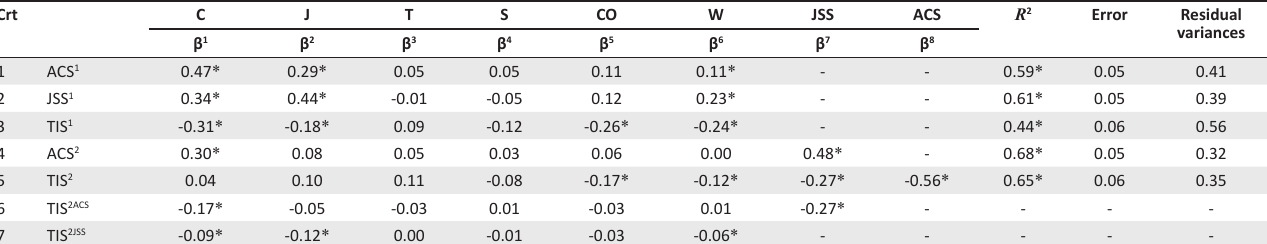
TABLE 5: The regression coefficients in the structural equation path model (EwC-on-Crt 1&2 ) Inter-correlation matrix of all variables included in the structural equation path model (EwC-on-Crt). Crt C